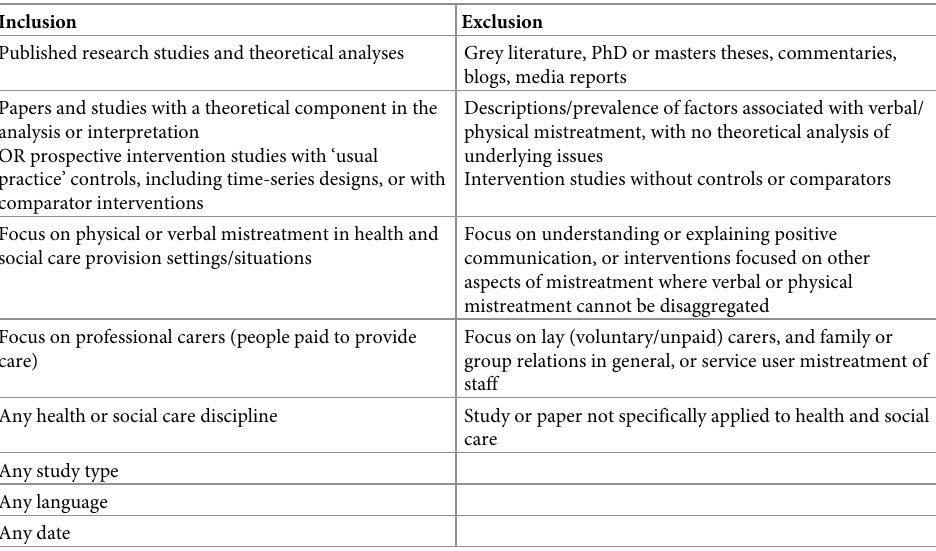
Table 1. Inclusion and exclusion